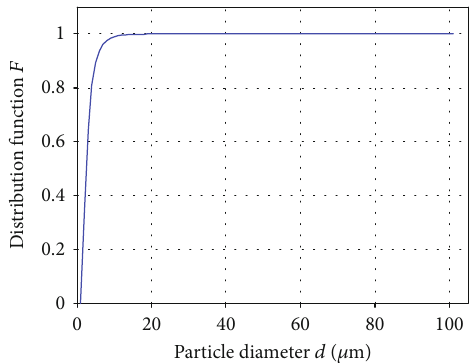
Figure 20: The contamination particle ’ s mass fraction distribution of